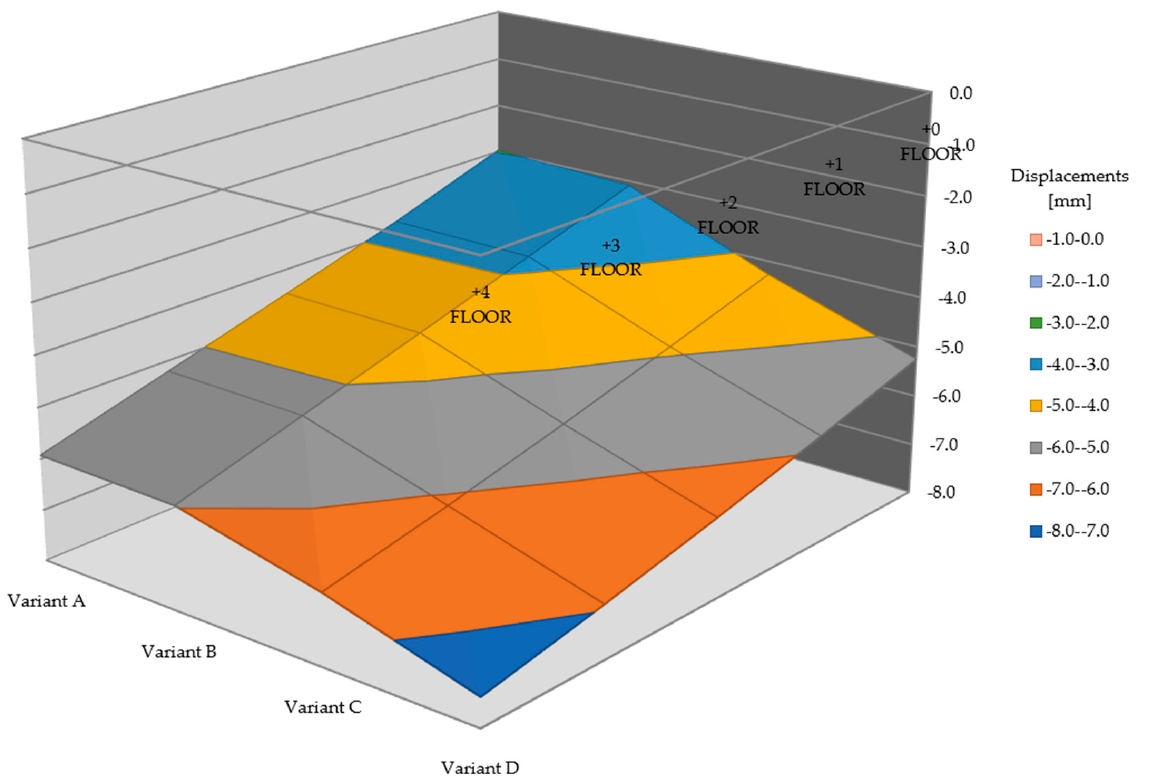
Figure 11. Graph of vertical displacements (in mm) obtained from numerical models of variants A, B, C, and D on the wall of the building at 1B Ludna Street at a distance of 6.1 m from the edge of the new building D (this point corresponds to the location of benchmark Rp30) with additional overground floors from 0 to 4.